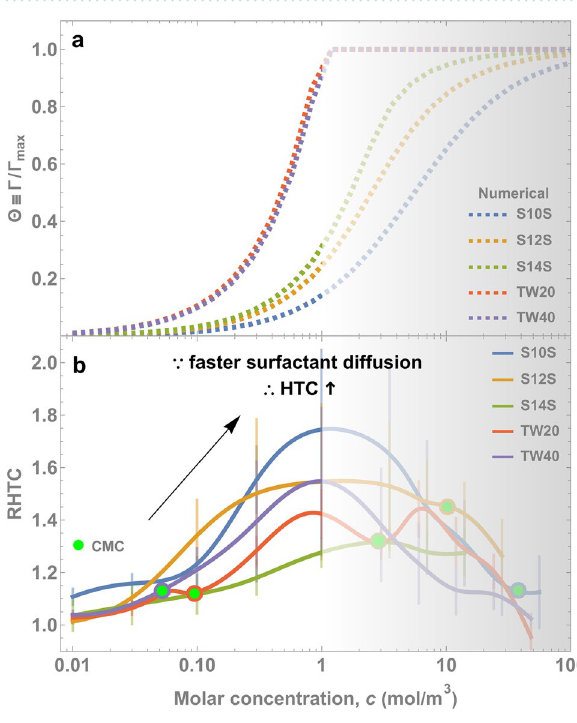
Figure 7. ( a ) We calculate the dynamic adsorption for a bubble lifetime of 20 ms (see Theory S.1, SI) using the Ward-Tordai equation 44 . The Ŵ increases with concentration because of the faster diffusion rate as quantified by Eq. (2). All surfactants begin to increase in Ŵ on the order of 0.1 mol/m 3 , which ( b ) coincides with the beginning of enhancement in